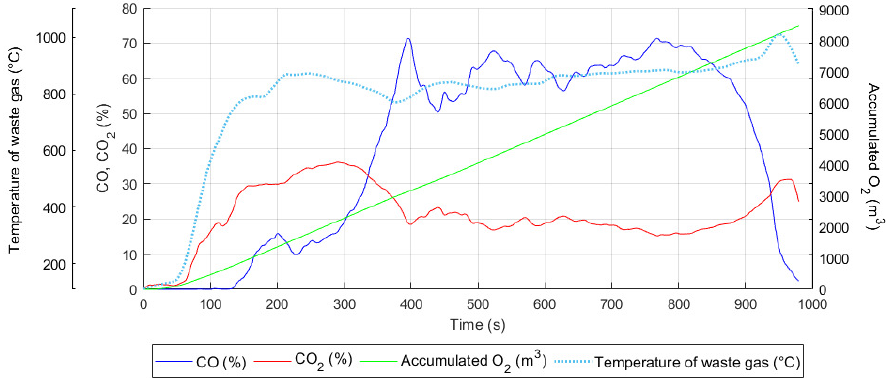
Figure 19. Dynamic input observations of the melting #5.